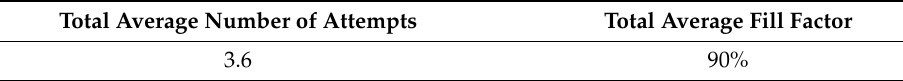
Table 4. Total average number of attempts and fill